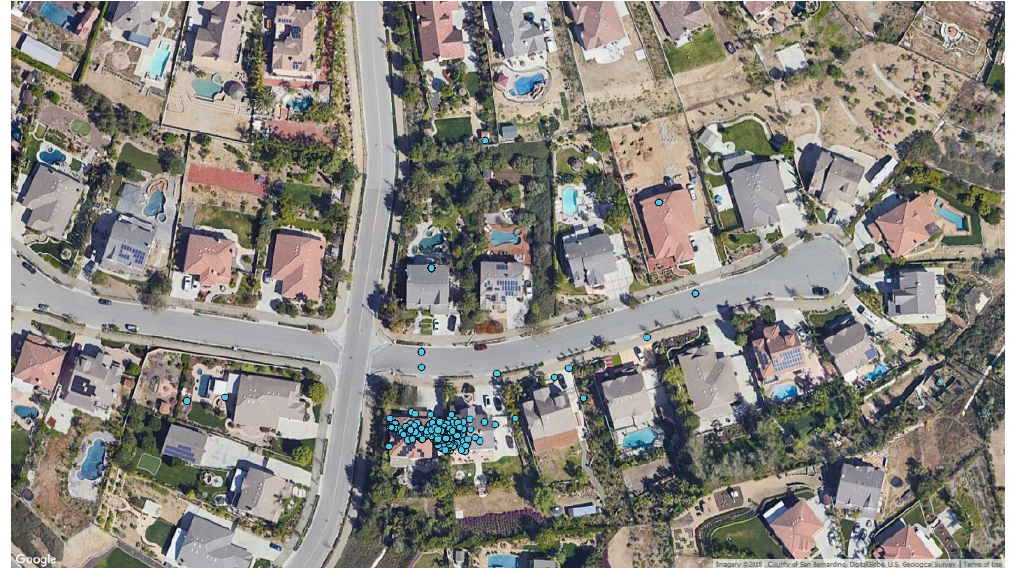
Figure 1: The spatial distribution of geotagged tweets around a Twitter user’s